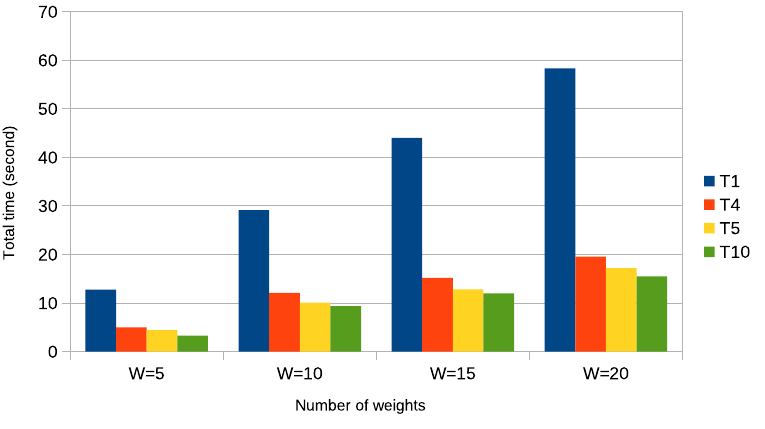
Figure 1. Time comparison when the proposed method applied to Neural Network training.